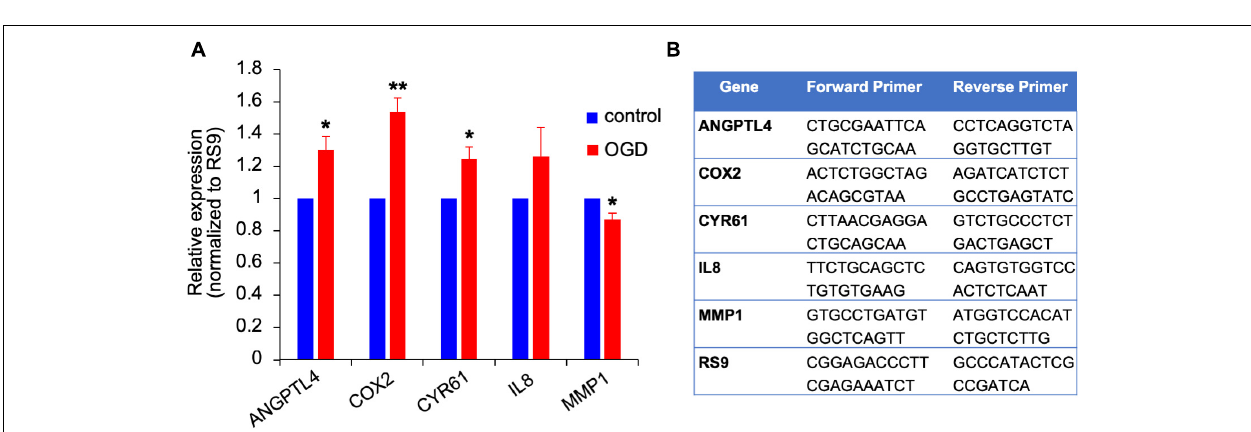
FIGURE 10 | Gene expression changes in OGD exposed metastatic melanoma cells. (A) The effect of OGD exposed astrocyte secreted factors on melanoma gene expression. Astrocytes were subjected to OGD or control conditions for 4 h followed by a 20 h reperfusion phase. Metastatic melanoma cells were treated for 24 h with the OGD or control conditioned media collected from the reperfusion phase. Total RNA was extracted and gene expression was determined by RT-qPCR. mRNA expression levels were normalized to the expression of RS9. Bars represent gene expression in cells treated with conditioned medium of “stroked” astrocytes normalized to gene expression in cells treated with control astrocyte conditioned medium mean ± SD of three independent experiments, ∗ p < 0.05, ∗∗ p < 0.01. (B) Primer sequences used for the qPCR analysis shown in (A,B)